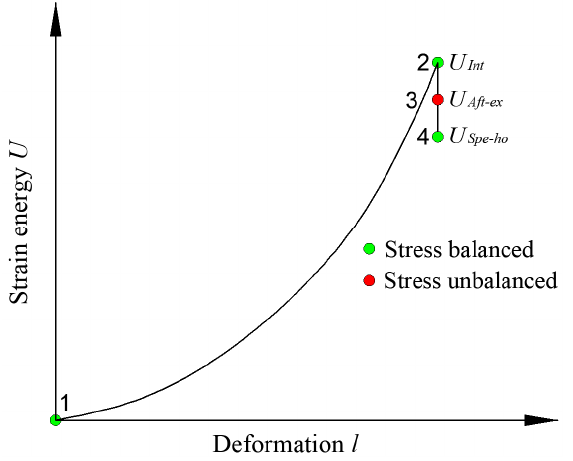
Figure 5. Strain energy change in specimen at different stages.